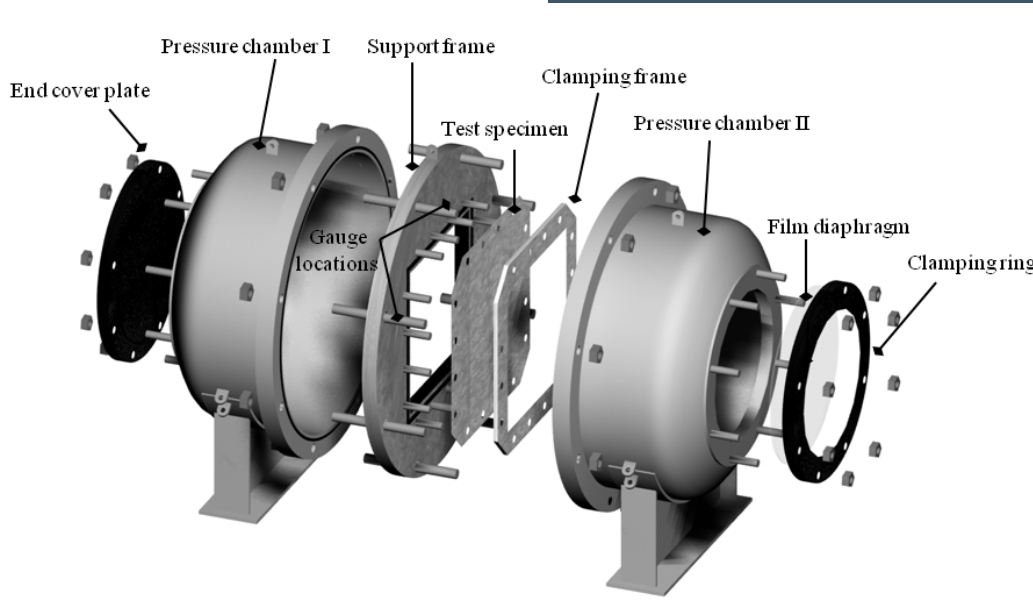
Figure 4. Expanded view of pulse pressure loading rig (PPLR).